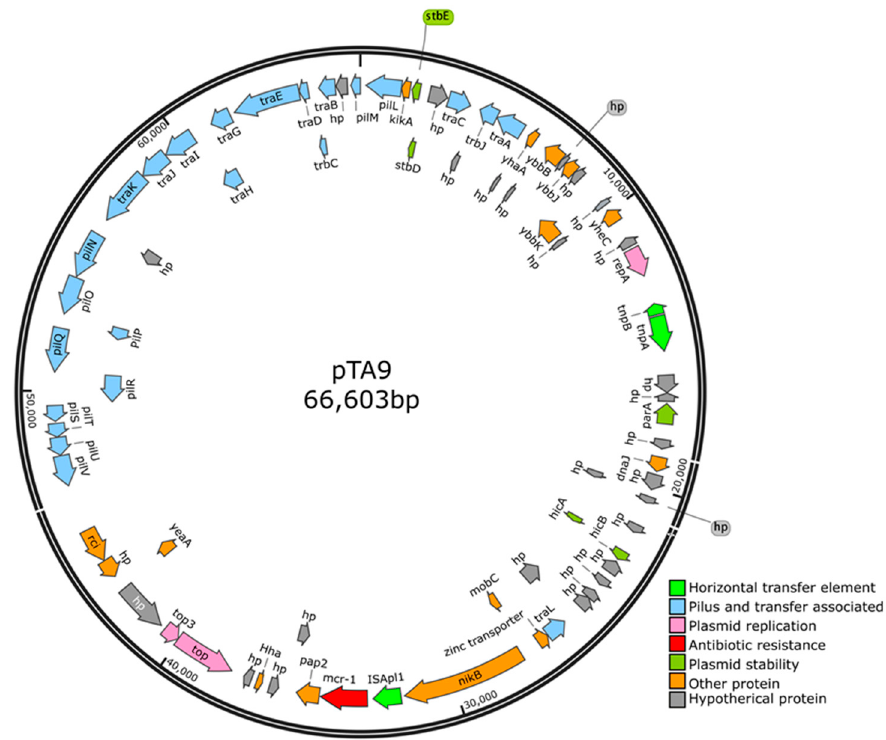
Figure 4. Genomic map of the representative mcr-1 -carrying plasmid pTA9 from the meat duck gut microbiota.